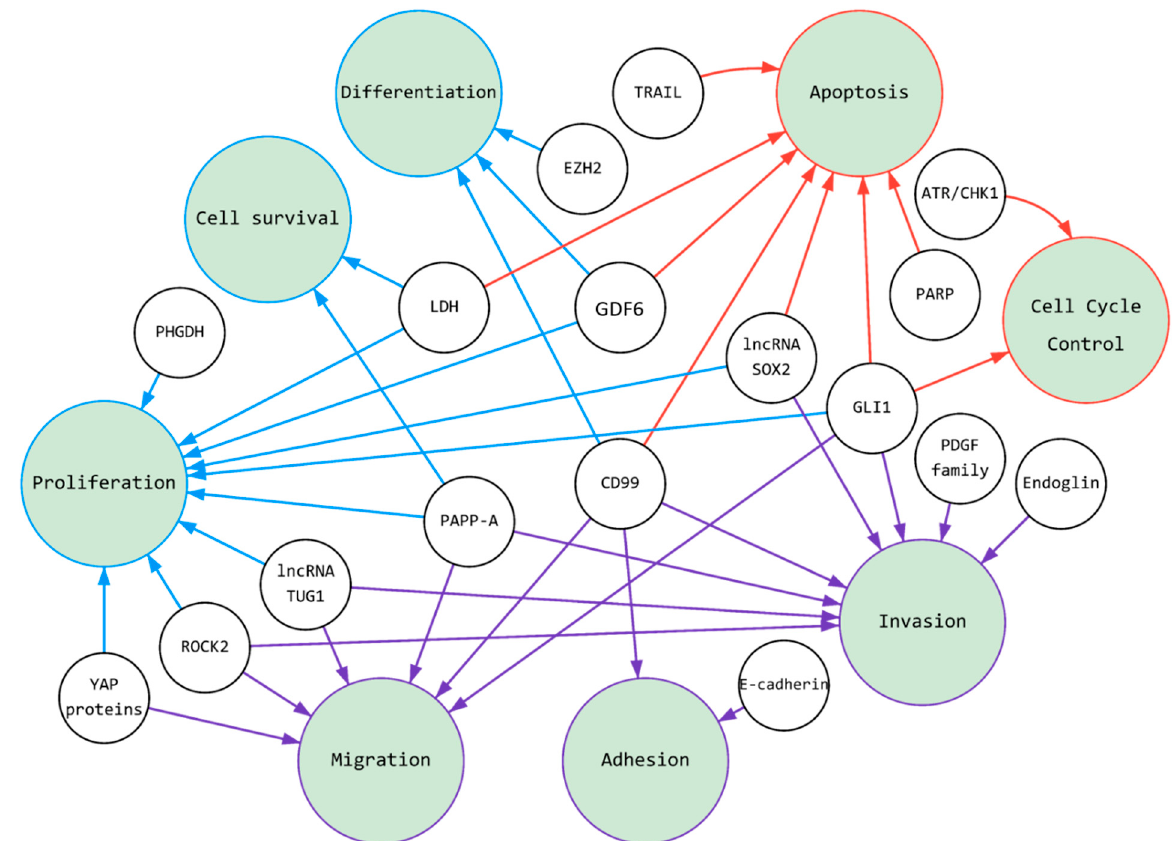
Figure 1. Schematic illustration of cancer pathways under control of ES’s fusion proteins: The figure summarizes our review of research active molecules over the past 10 years. The various domain of ES-produced fusion oncoproteins required for the activation of gene expression, and their products, such as RNA or proteins regulate cellular proliferation, apoptosis and migration, for example. All together with induced cell signaling cells gain oncogenic traits and transformation. Small circles are active molecules, large circles are cellular processes (see the hallmark of cancer). Colors in the figure are correlated to organizational divisions in the review for ease of perception. There are three colored clusters: purple (Section 3.1. Targeting of ES Pressure on Adhesion, Migration, and Invasion), blue (Section 3.2; Targeting of Ewing Sarcoma Cells with a Focus on Proliferation, Cell Differentiation, and Cell Survival) and red (Section 3.3; Targeting of ES: Induction of Apoptosis and Cell Cycle Arrest).